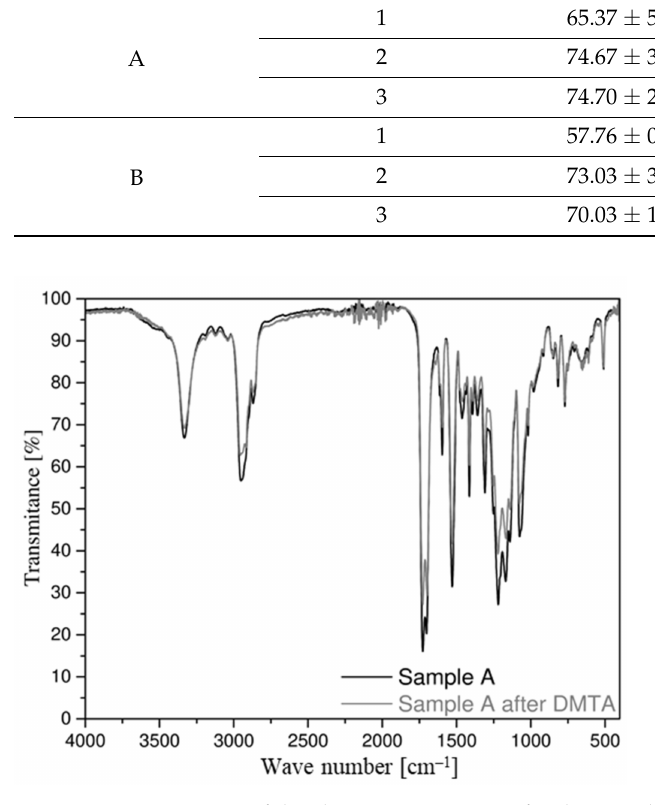
Figure 11. Comparison of the absorption spectrum for the sample A of the drive belt.